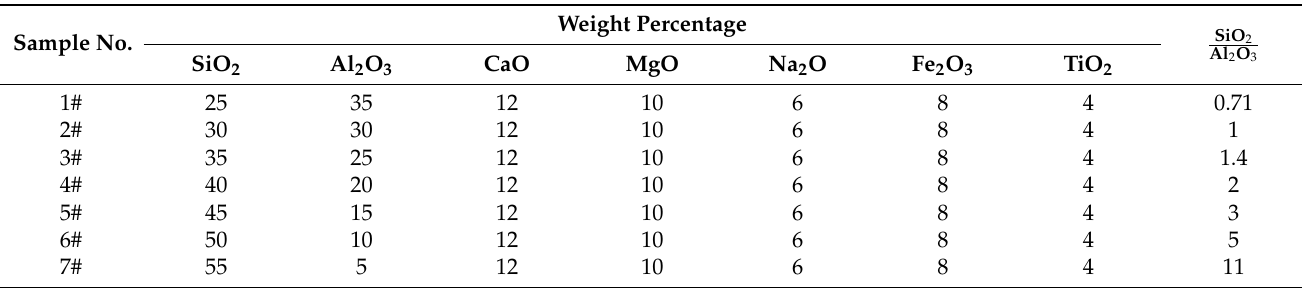
Table 2. Composition of red mud and number of